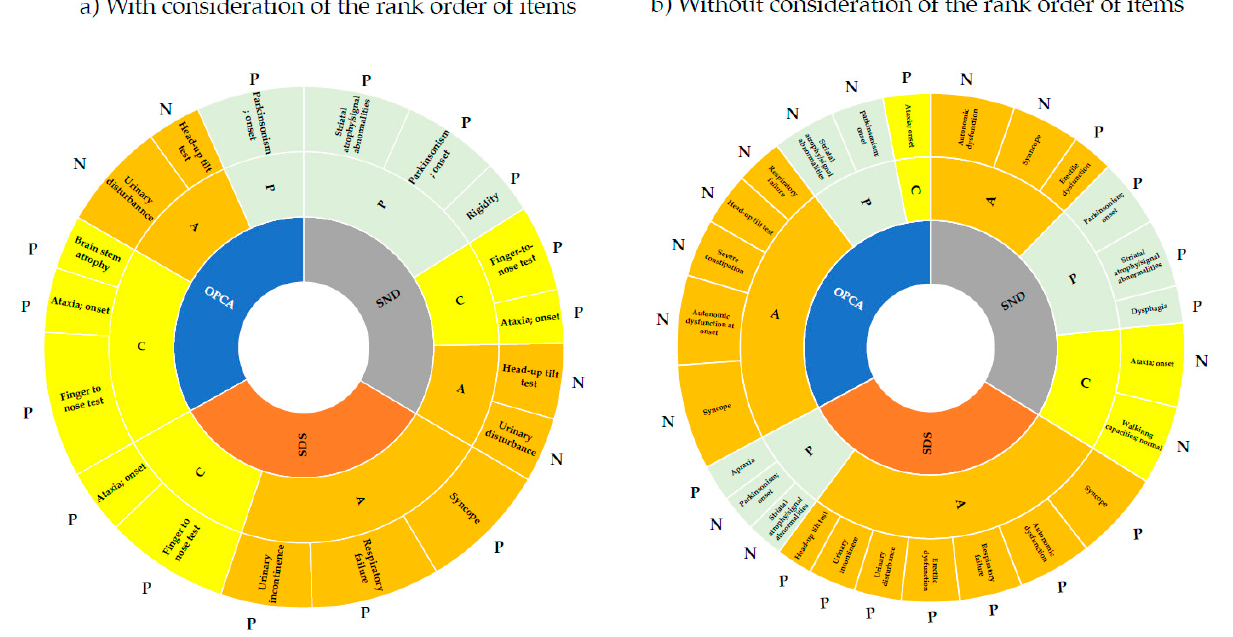
Figure 1. Features involved in diagnosis of MSA subtypes using machine learning. The items in Table 6a,b were divided into three components that were strongly associated with autonomic dysfunction (A), parkinsonism (P), and cerebellar ataxia (C). Analyses were performed with ( a ) and without ( b ) considering the order of severity of items for neurological findings and ADL. Based on the weight value, those with a strong relationship with the subtype were designated as P (positive) and those with a weak relationship with the subtype were designated as N (negative).